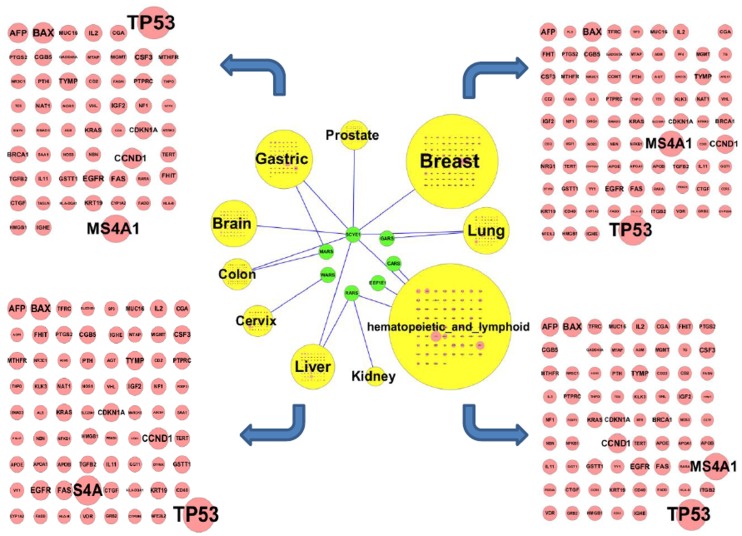
Cancer-associated interactions between 23 ARSs and AIMPs, and three genesets.3501 genes were selected by manual curation, clinical examination and causal relationship to cancer. Using 11 public database showing the curated interactions of human proteins (HPRD, BioGRID, KEGG, Reactome, BIND, MINT, IntAct, InnateDB, DIP, STRING, and PharmDB), we further selected 124 DTGs and 404 genes as PPIs of ARSs. Using a cancer-associated interactions analysis, a cancer-association map was established to display how much ARSs and AIMPs could be differently interacted to ten different cancers. Each brown node indicates each gene of respective cancer and each node size indicates the degree of cancer-dependent co-association of a gene. Line indicates the co-association between ten cancers and seven ARSN. The cancer node size indicates the number of interactions with the brown node gene. Seven components of ARSN (green nodes) show relatively higher cancer-associated network.